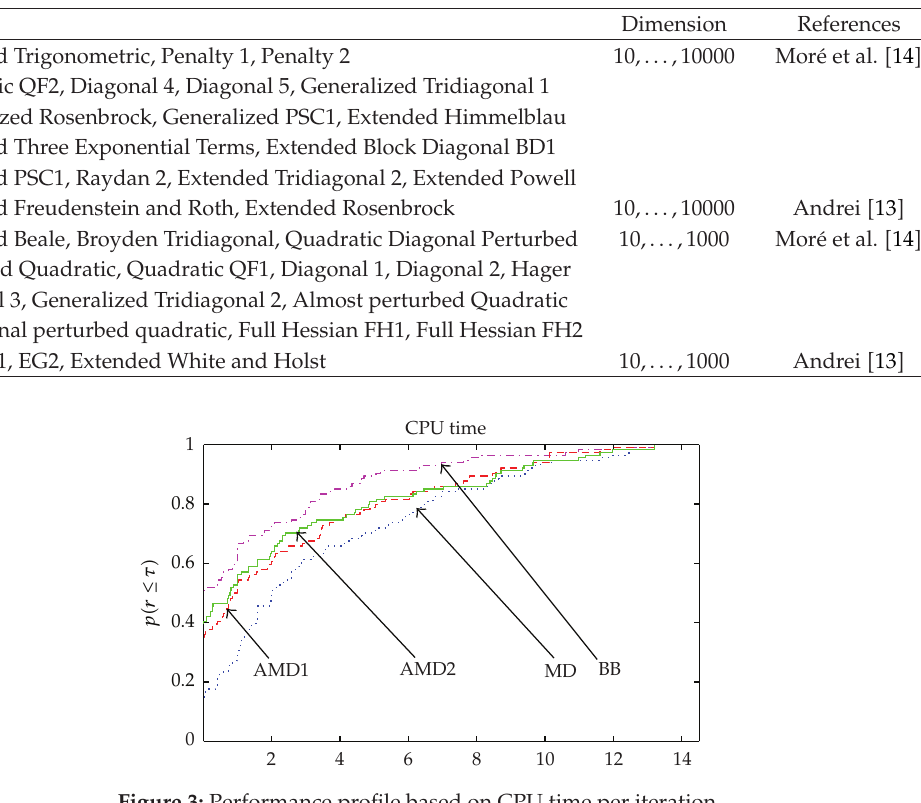
Table 1: Test problem and its dimension.